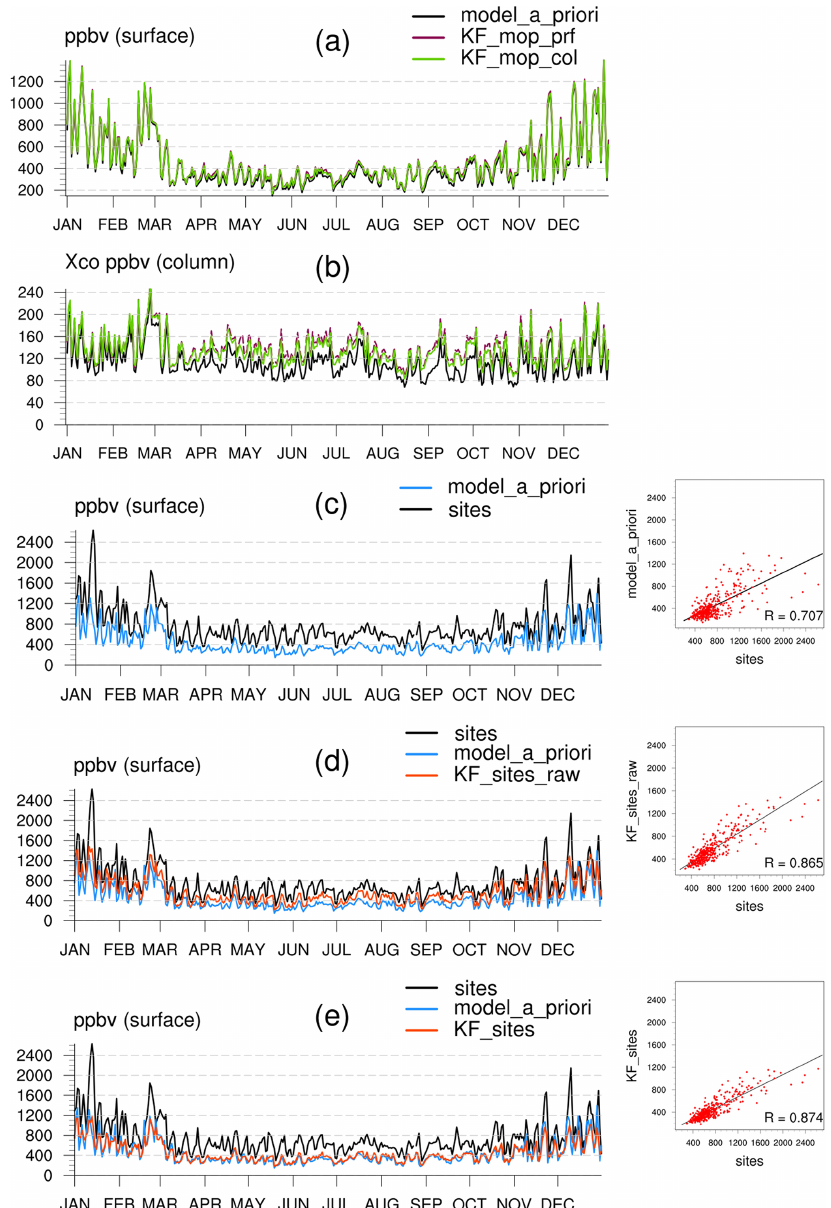
Figure 2. (a) Surface CO concentrations over NCP in 2019 from a priori simulation and Kalman filter by assimilating MOPITT CO; (b) same as panel (a) , but for CO columns; (c) surface CO concentrations from a priori simulation and MEE observations; (d) surface CO concentrations from a priori simulation, MEE observations and Kalman filter by assimilating MEE CO; (e) surface CO concentrations from a priori simulation, MEE observations and Kalman filter by assimilating normalized MEE